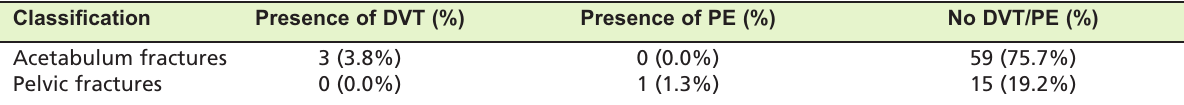
Incidence of pre-operative DVT and PE in patients with pelvic and acetabulum fractures Table II: